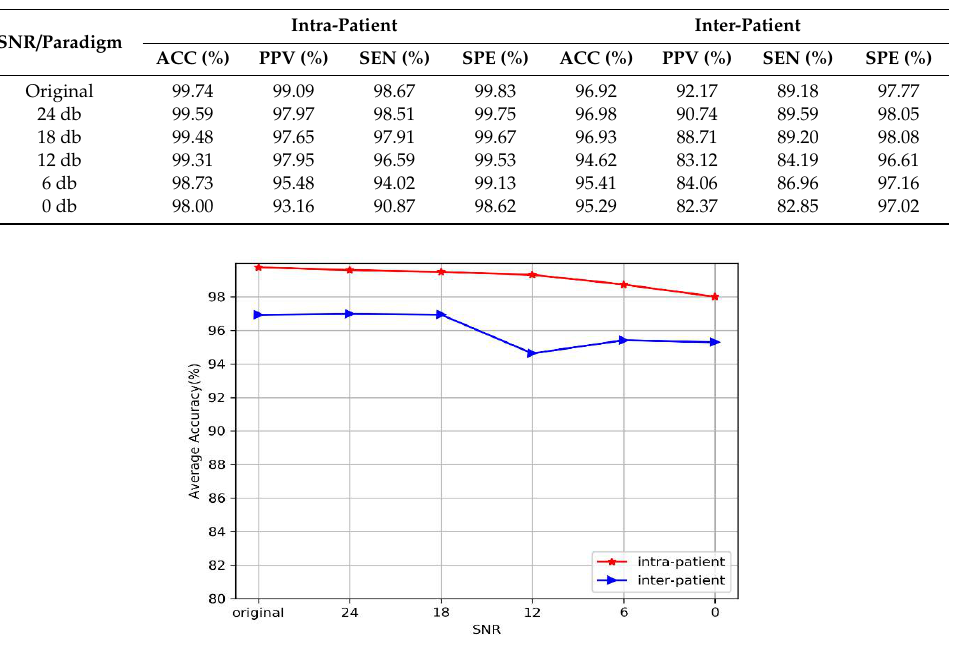
Figure 12. Plots of average performance of our model at different SNRs under intra-patient and inter-patient paradigms.